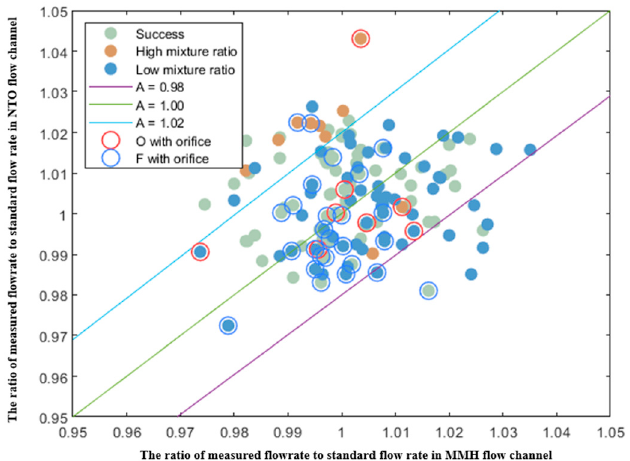
Figure 1. The mixture ratio results of a batch of thrusters in the firing test after orifice adjustment.